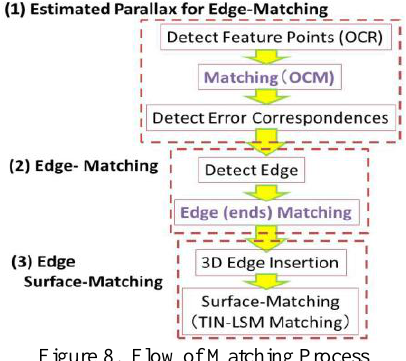
Figure 8. Flow of Matching Process